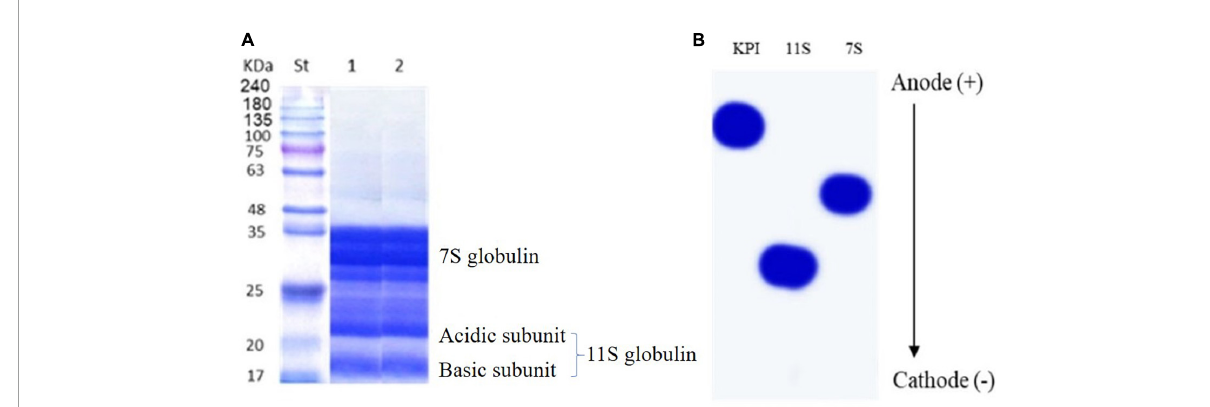
a predominance of E. coli (40%) either single or mixed